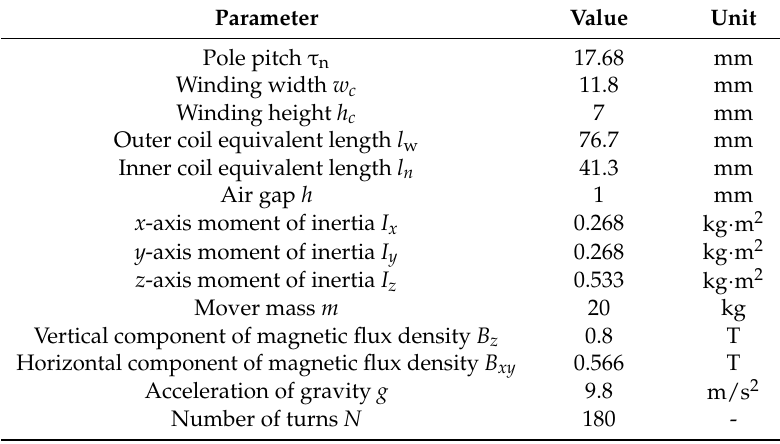
Table 1. The planar motor